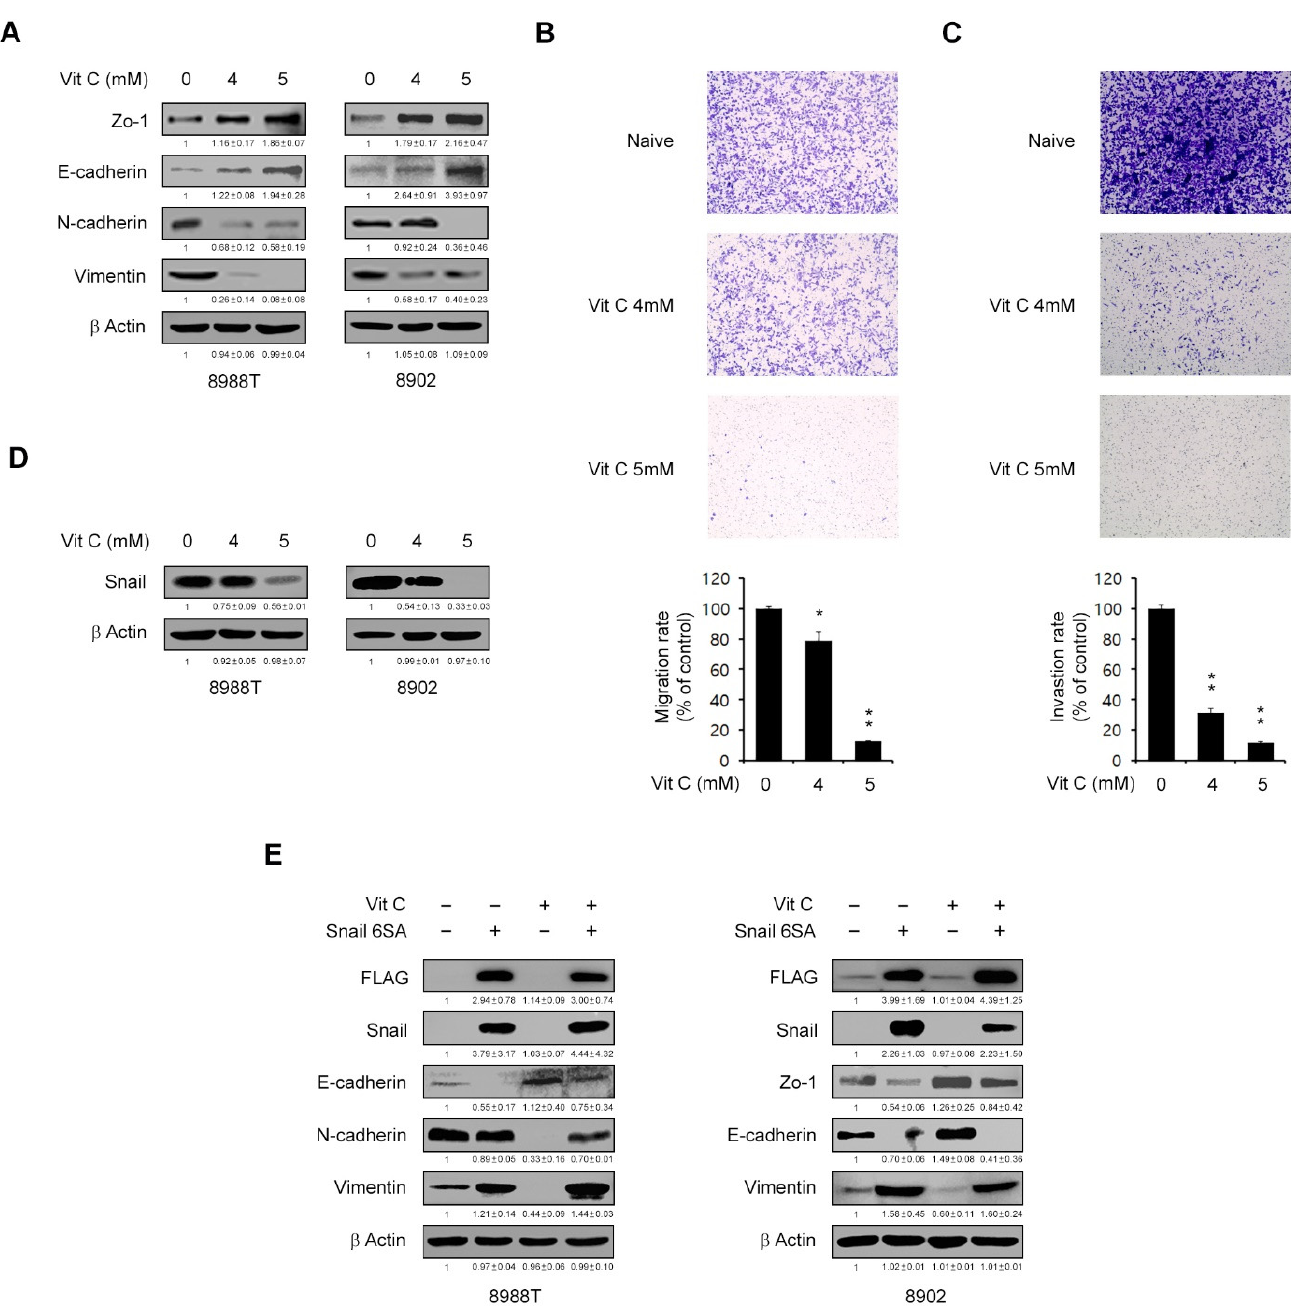
Figure 4. High-dose vitamin C suppresses the invasiveness and metastasis of PDAC cells. ( A ) PDAC cells were treated with vitamin C (4 or 5 mM) for 24 h and immunoblotted with the indicated antibodies. Error bars with the mean ± s.d. of three independent experiments. ( B ) Migration assay for 8988T cells loaded into the upper chamber of a 0.4% gelatin-coated transwell and treated with vitamin C (4 or 5 mM) for 24 h in the lower chamber. The bar plot represents the percentage of cell migration for each panel. ( C ) Invasion assay for 8988T cells seeded into the upper chamber of a Matrigel (1 mg/mL) coated transwell and treated with vitamin C (4 or 5 mM) for 24 h in the lower chamber. The bar plot represents the percentage of cell invasion for each panel. ( D ) PDAC cells were treated with vitamin C (4 or 5 mM) for 24 h and immunoblotted with the indicated antibodies. Error bars with the mean ± s.d. of three independent experiments. ( E ) PDAC cells expressing FLAG-Snail 6SA were treated with vitamin C (5 mM) for 24 h and immunoblotted with the indicated antibodies. Error bars reflect the s.d. of three independent experiments; * p < 0.05, ** p < 0.01.